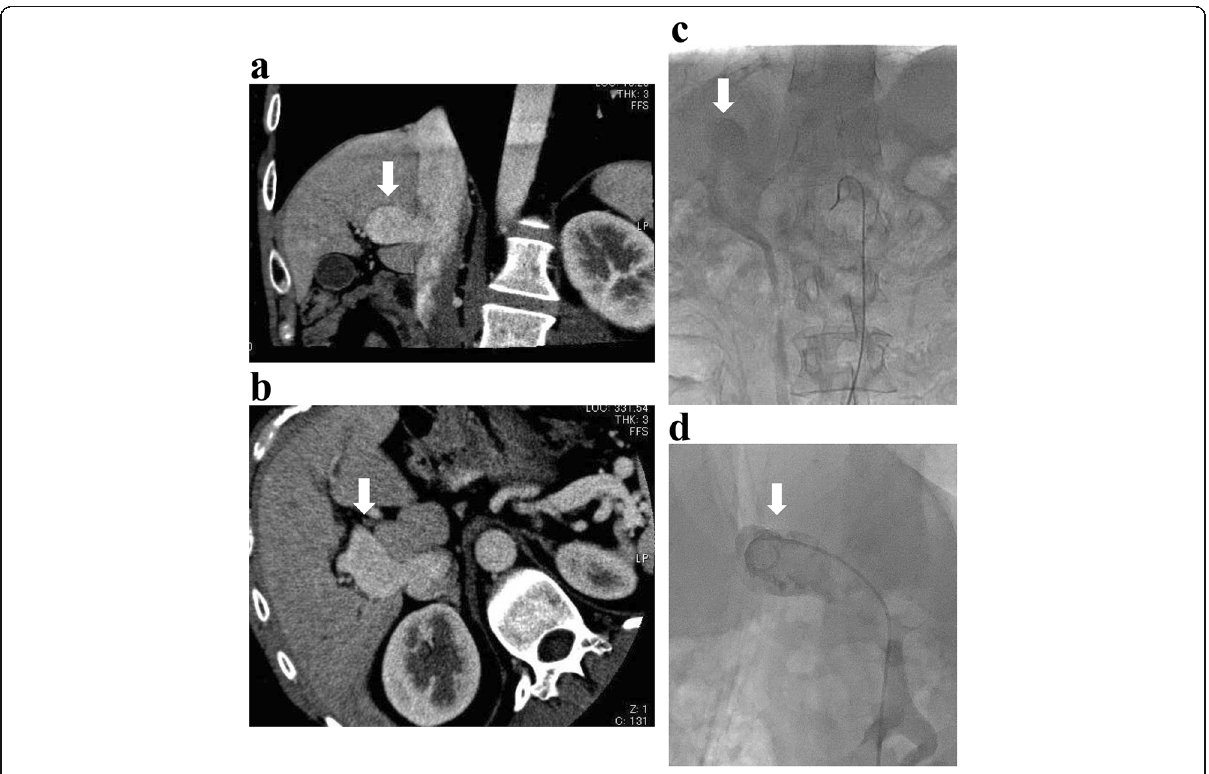
Fig. 1 The findings of contrast-enhanced multidetector computed tomography (MDCT) and transcatheter angiogram. a , b Contrast-enhanced MDCT showing an abnormal venous connection between the left portal vein and the inferior vena cava (IVC; white arrows), suggestive of patent ductus venosus. c , d Elective superior mesenteric angiogram with delayed venous phase image and transfemoral venography showing the same findings as those of